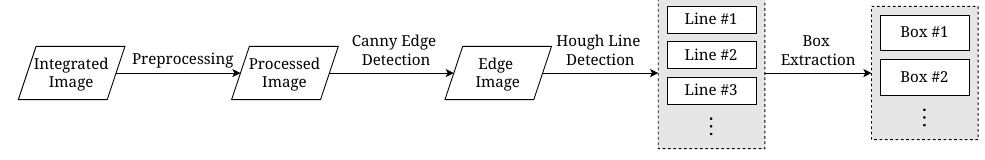
Figure 3. The workflow of parking space extraction.